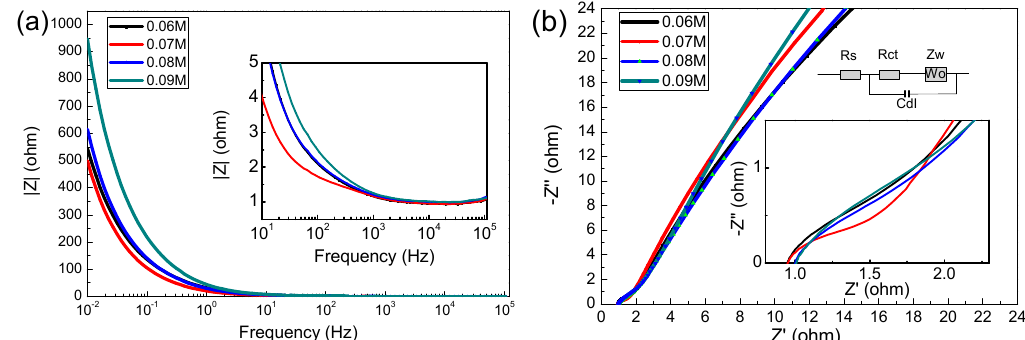
Figure 7. ( a ) Impedance modulus as a function of frequency; ( b ) electrochemical impedance spectra (Fitting circuit equivalent model are inset).